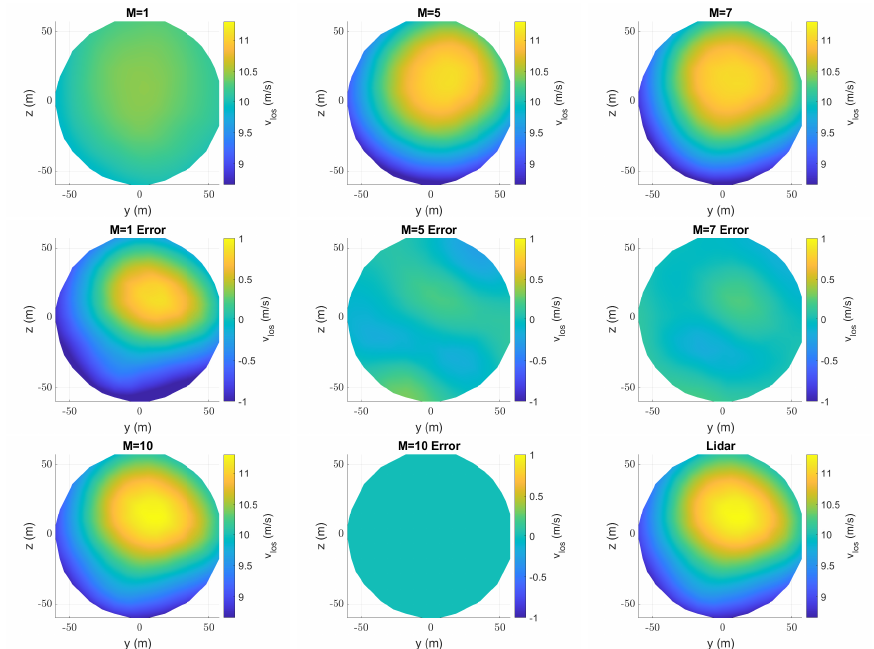
Figure 7. CBL case: Reconstruction of the line-of-sight ( v los ) velocity snapshot at an arbitrary time instant t = 256 s with different numbers of modes ( M = 1,5,7 and 10) and their corresponding errors with respect to full lidar measurements (bottom right-hand plot captioned as